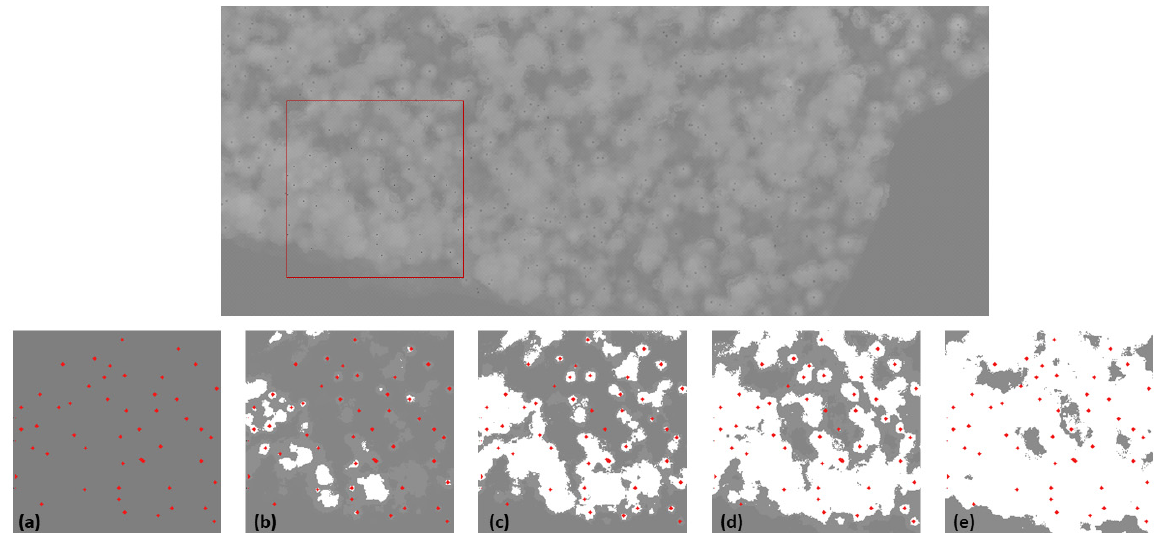
Figure 5. Fixed-side-length windows over the CHM sliding on different heights from above with ( a ) expert-annotated treetop positions, then ( b ) the initial tallest region appearing, ( c , d ) new appearances and, finally, ( e ) the region’s highest intensity marked as treetops.